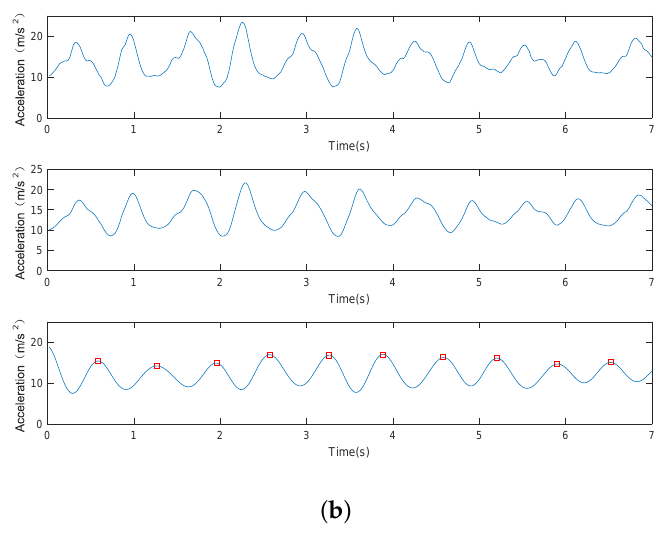
Figure 8. Data processing for step detection. ( a ) accelerometer in the hat; ( b ) accelerometer in hands.